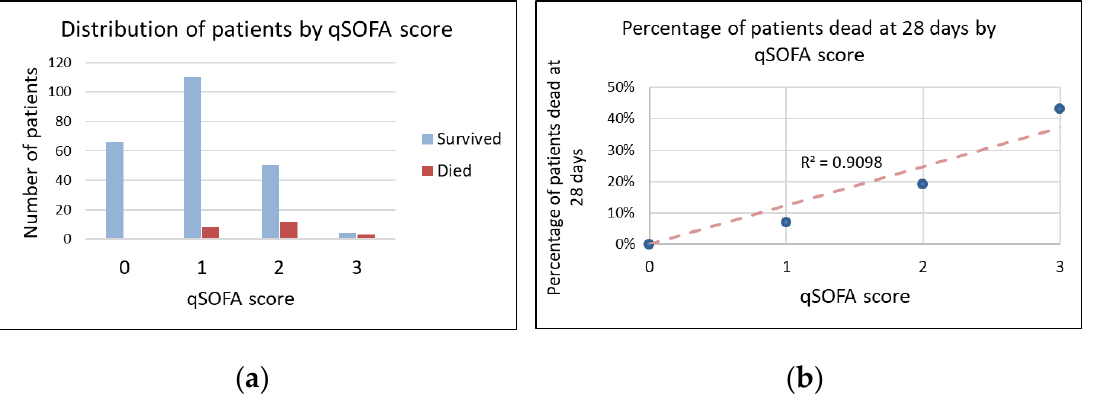
Figure 2. Distribution of patient mortality based on quick sequential organ failure assessment (qSOFA) score. ( a ): Distribution of patients by qSOFA score; ( b ): Percentage of patients dead at 28 days by qSOFA score.